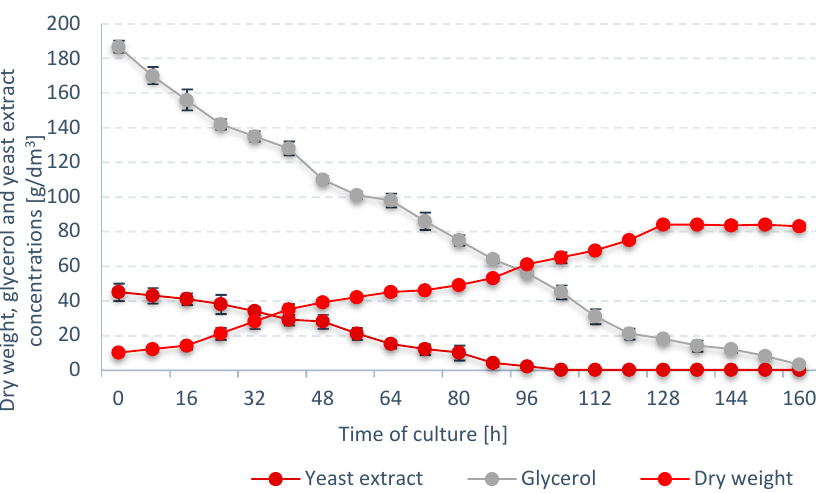
Figure 6. Trends in dry weight, glycerol, and yeast extract concentrations in the batch culture optimized for S. limacinum E20 growth.